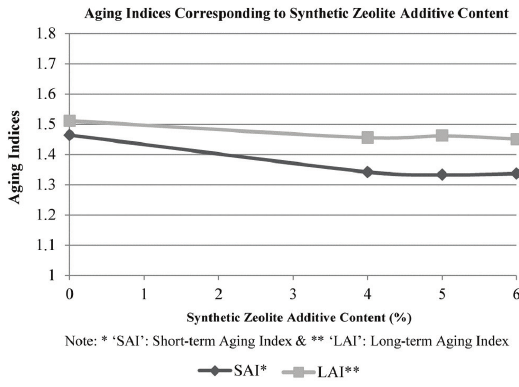
Figure 6. AI values corresponding to additive contents for synthetic zeolite modified